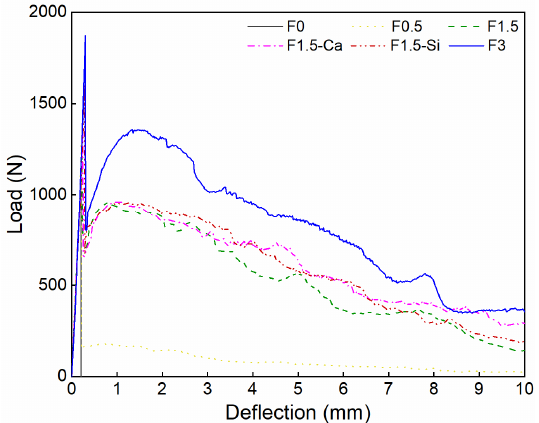
Figure 14. Average load-deflection curve of LWAC with coir fibers of various contents and differ- ent treatments. Figure 15. Flexural fracture characteristic of LWAC. The left sample without coir fibers and the right one with 1.5% coir fibers.